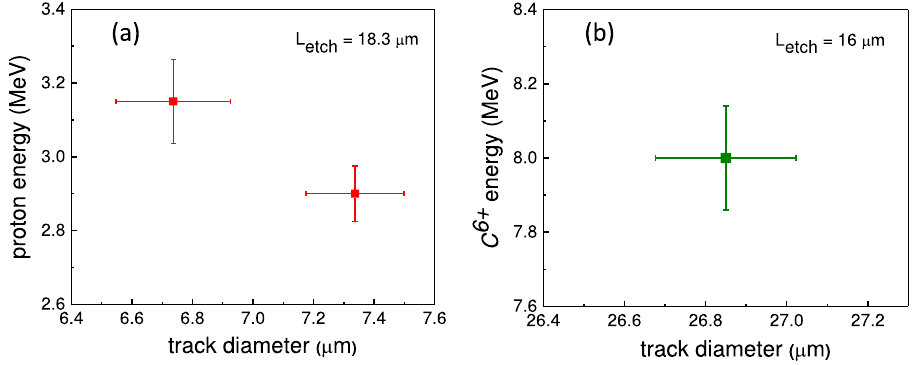
Figure 8. Track diameter dependent energy resolution of CR-39. Energy resolution of CR-39 for ( a ) protons nearly 3 MeV and ( b ) 8 MeV Carbon ions based on the track